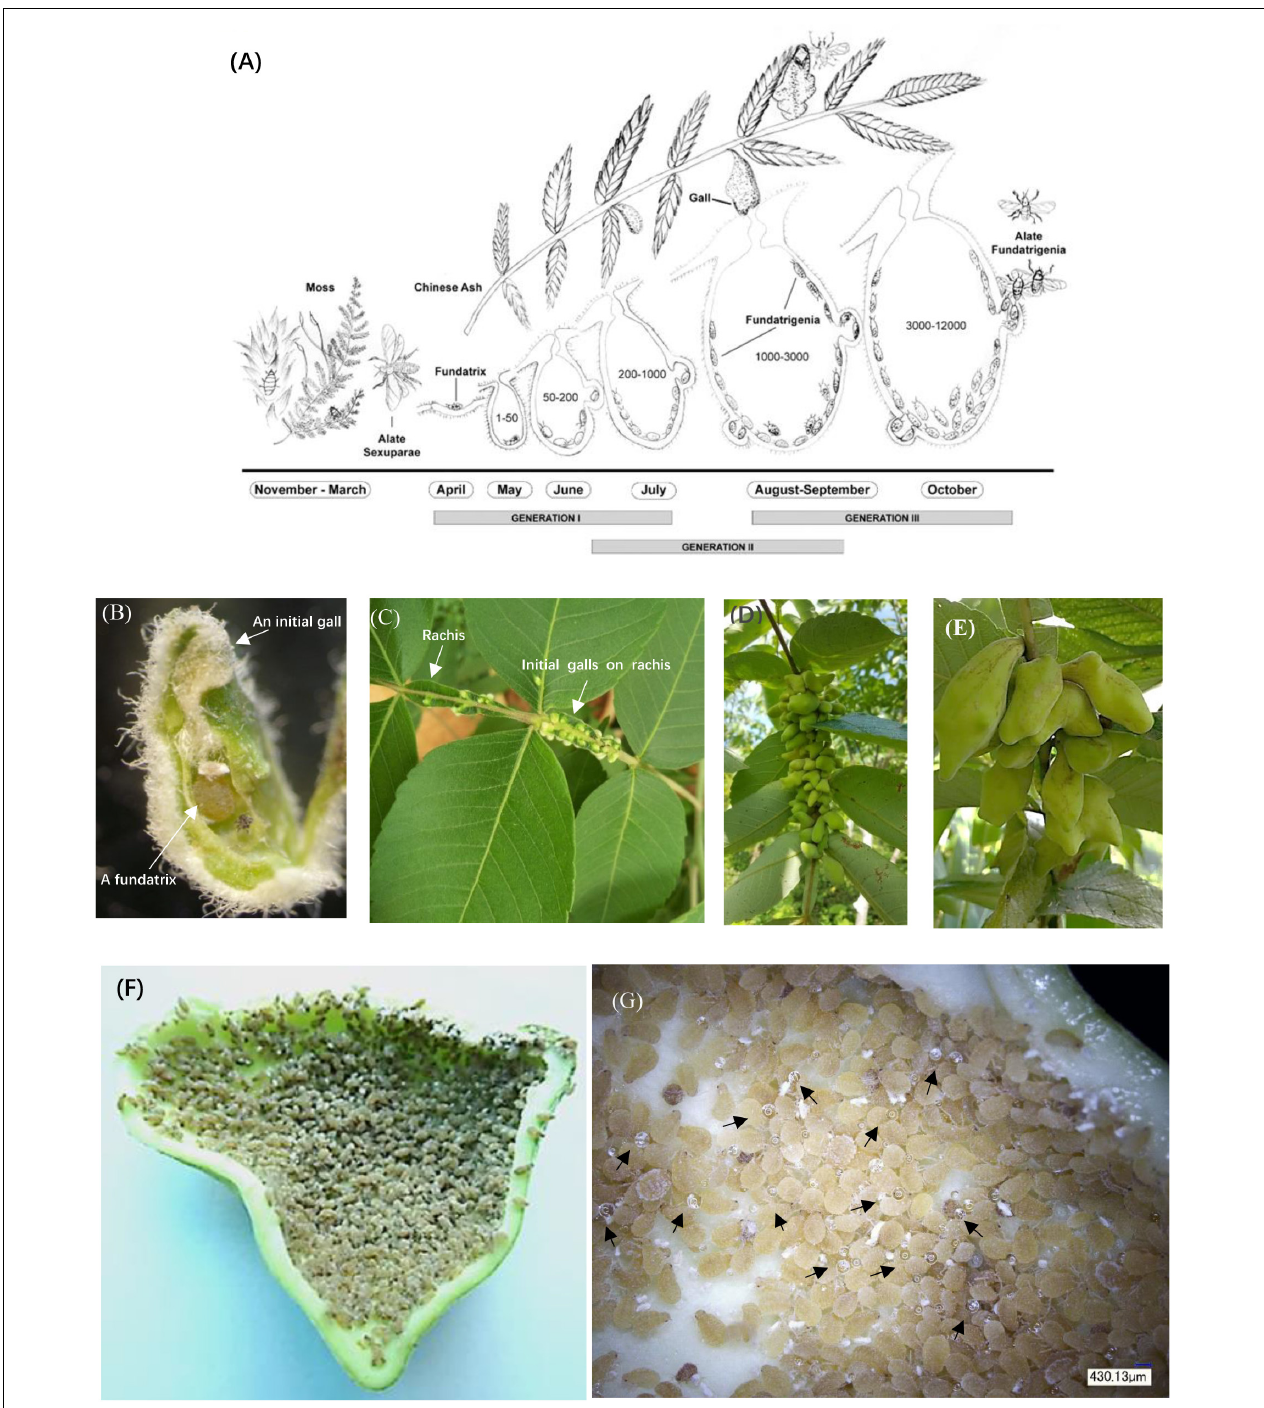
FIGURE 1 | Life cycle and anatomical features of horned galls. (A) Life cycle of Schlechtendalia chinensis . S. chinensis is a heteroecious species and requires two host plant species, a moss species and the Chinese ash. After overwintering in moss, winged (alate) sexuparae fly to trunks of the primary host Chinese ash ( Rhus chinensis ), where they deposit male and female sexuales on the branch surface. This is the only sexuparous stage in its life cycle. After mating, each female produces a single apterous fundatrix, which initiates gall formation on the host tree. Within a gall, three generations of fundatrigenia are produced parthenogenetically from the fundatrix. Late in the season, winged fundatrigenia fly away from dehisced galls to the winter host (moss), where the life cycle is completed by the formation of parthenogenetically produced winged Sexuparae. (B) A fundatrix and its newly induced gall at the initial stage. (C–E) Gall development in different stages with (C) in July, (D) in August, and (E) in September. (F) High density of aphids living inside a late-stage gall. (G) Aphid-excreted honeydews inside a gall. Black arrowheads indicate honeydew droplets.